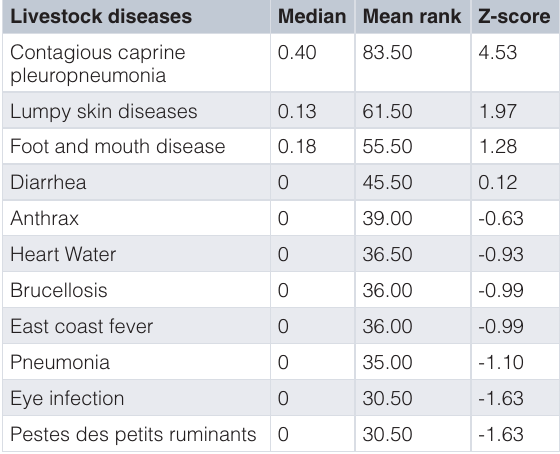
Table 1. Ranks of livestock diseases based on their impact according to